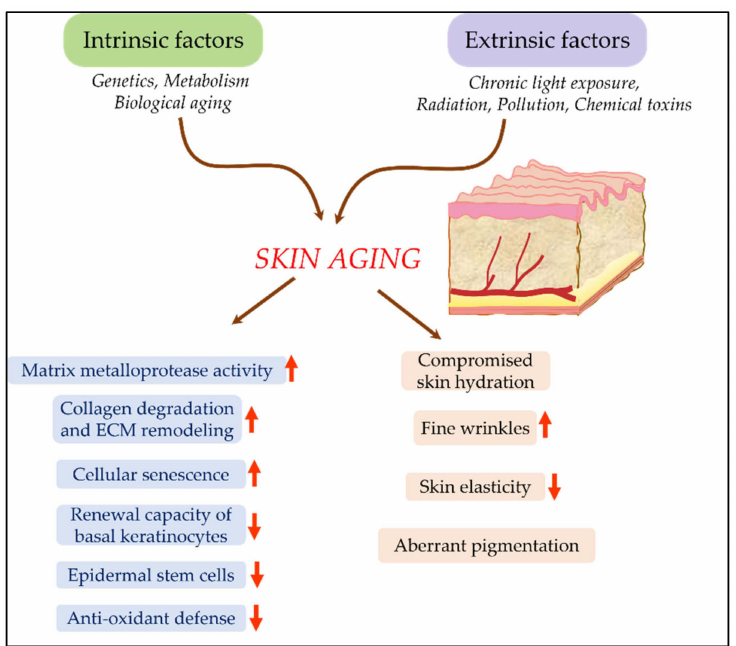
Figure 3. Cellular and morphological characteristics of skin aging. Skin aging can be due to either intrinsic or extrinsic factors. Along with age, there is an increase in the enzymes that degrade collagen and extracellular matrix. This results in reduced skin elasticity, leading to the appearance of external features of aging such as fine wrinkles, skin dehydration, and aberrant pigmentation. The up and down arrows in red indicate increase and decrease,